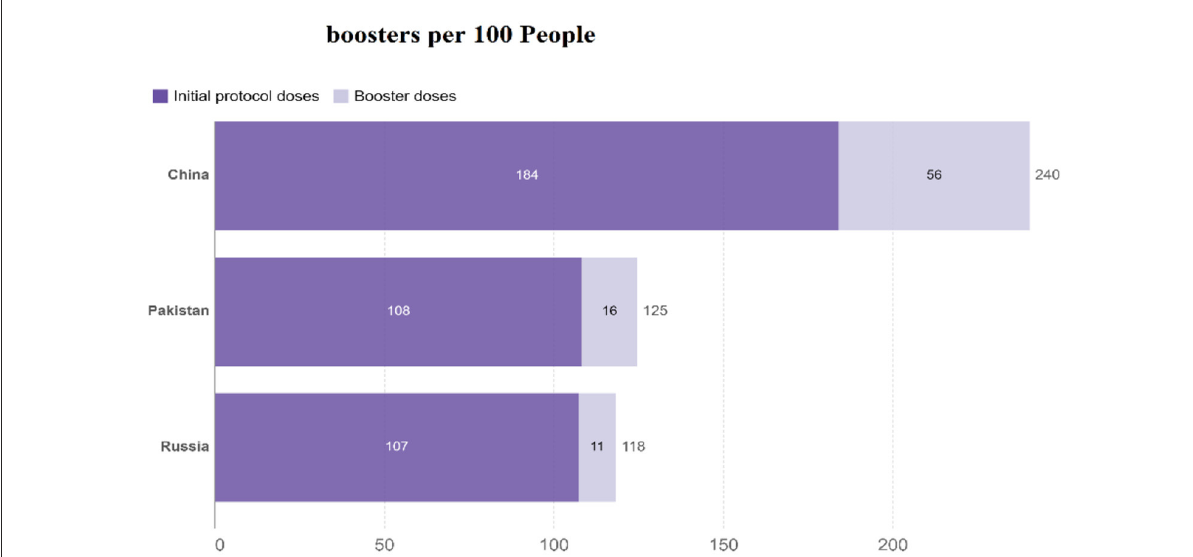
FIGURE4 COVID-19 vaccine initial doses and boosters per 100 people. Data source: https://github.com/owid/covid-19-data/tree/master/public/data/ vaccinations/locations.csv, only rely on figures that are verifiable based on public official, August 13, 2022.